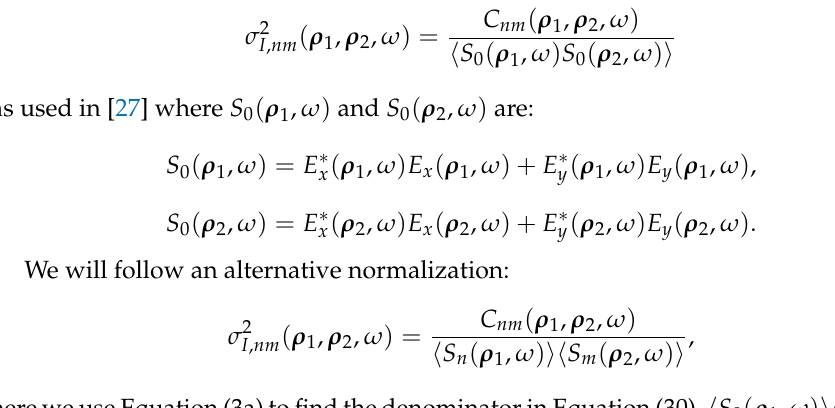
= 0.3 e − i π /6 , C 2 = 1 × 10 − 16 m − 2/3 , l yx n